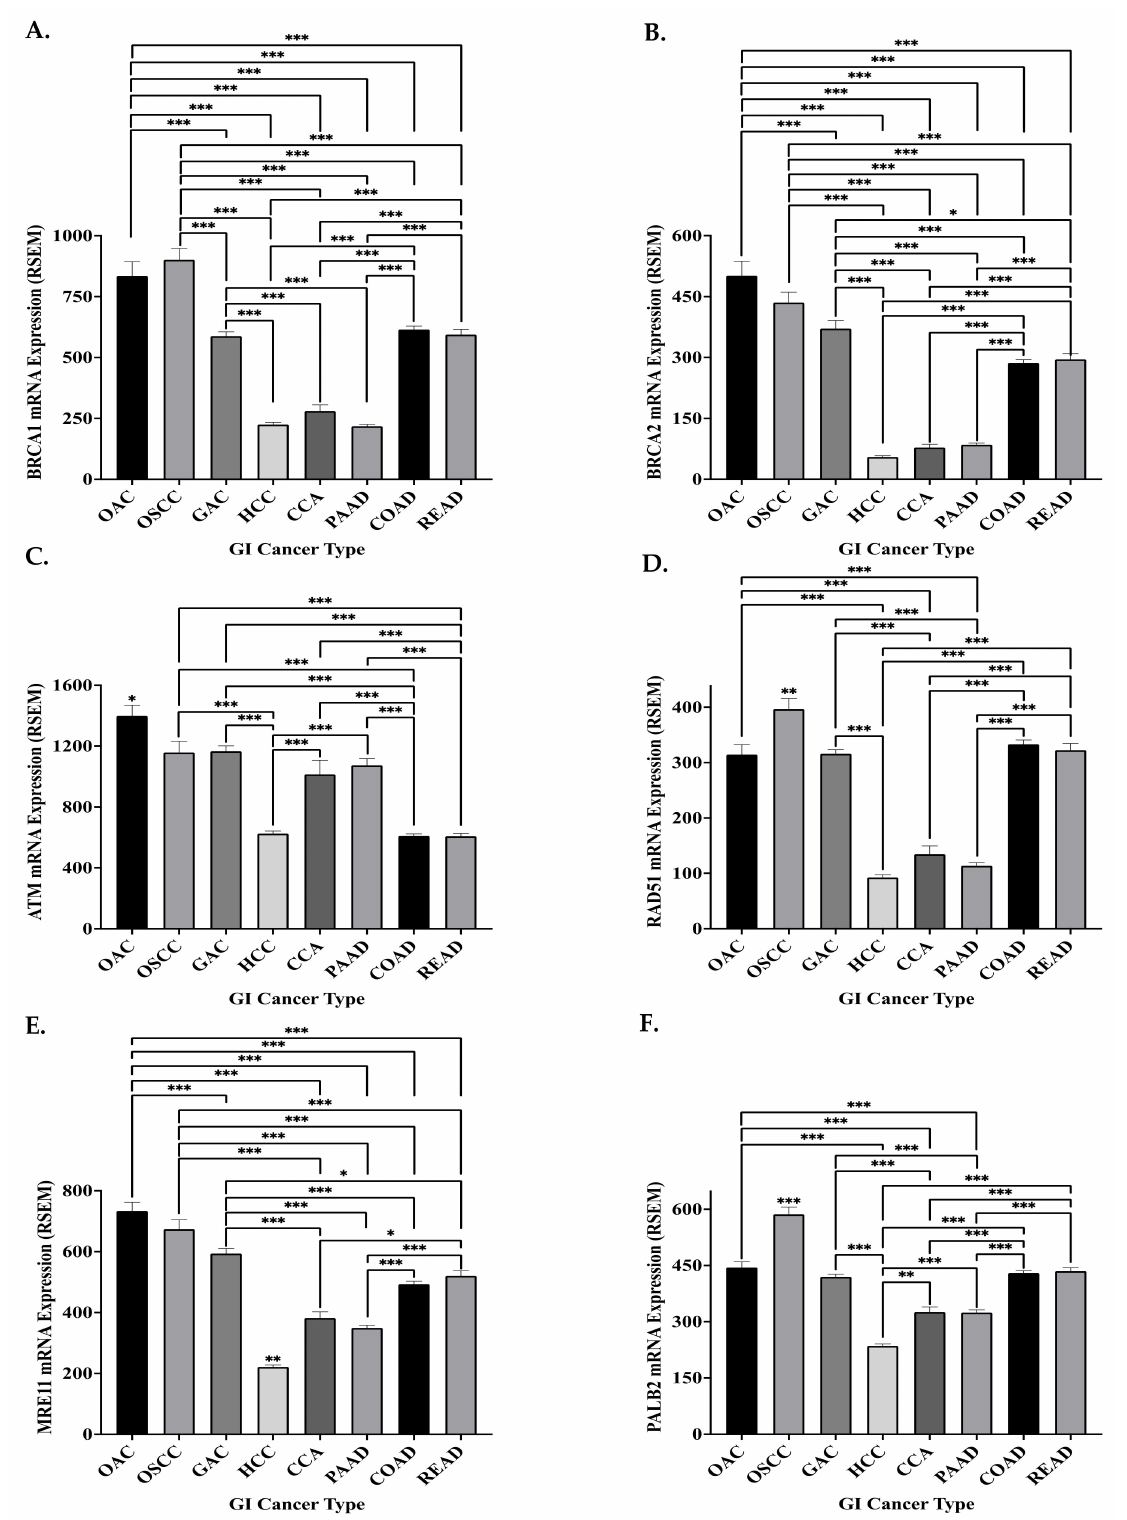
Figure 4. Mean mRNA expression of HR genes in GI cancers. Mean mRNA expression of ( A ) BRCA1 ( B ) BRCA2 ( C ) ATM ( D ) RAD51 ( E ) MRE11 and ( F ) PALB2 in GI cancers presented as the mean RSEM ± SEM. OAC, n = 97; OSCC, n = 94; GAC, n = 412; HCC n = 363; CCA, n = 36; PAAD, n = 177; COAD, n = 377; READ, n = 154. Statistical analysis was performed using one-way ANOVA with Tukey’s multiple comparison post-hoc test, * p ≤ 0.05, ** p ≤ 0.01, *** p ≤ 0.001. When significance is not directly comparing two groups, it is significant in comparison to all other